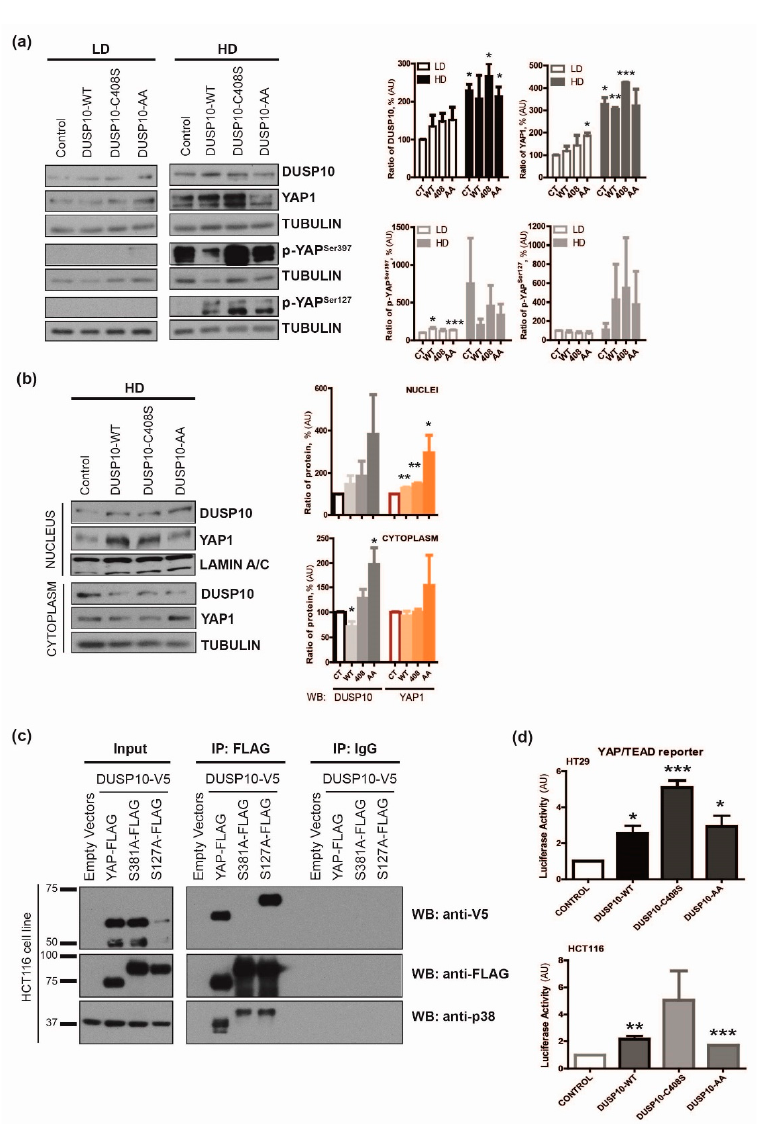
Figure 4. DUSP10 interacts with YAP1 through Ser397 residue. ( a ) Expression of DUSP10, YAP1, p-YAP Ser397 , and p-YAP Ser127 proteins in DUSP10-wild type (DUSP10-WT), phosphatase catalytic site mutant (DUSP10-C408S), and p38 binding site mutant (DUSP10-AA) HT29 cell line in LD and HD. TUBULIN is the control protein. (Top) A representative image of three independent experiments. (Bottom) Quantification of all blots performed (mean ± SEM; Student’s t -test; * p < 0.05, ** p < 0.01, *** p < 0.001). ( b ) Analysis of DUSP10, YAP1, and p-YAP Ser127 proteins from nuclei and cytoplasm extracts of HT29 DUSP10 mutant cell lines in HD. LAMIN A / C and TUBULIN are used as nuclear and cytoplasm control proteins, respectively. (Left) A representative image of three independent experiments. (Right) Quantification of all blots performed (mean ± SEM; Student’s t -test; * p < 0.05, ** p < 0.01). ( c ) Immunoprecipitation of YAP-FLAG and detection of DUSP10 and p38 in HCT116. DUSP10-V5 and YAP-FLAG plasmids were co-transfected into the cell line and detected by anti-FLAG and anti-V5 antibodies, respectively. YAP1 wild type (YAP1-FLAG) and mutant (S381A-FLAG, S127A-FLAG) plasmids were immunoprecipitated with anti-FLAG. Representative images of three independent experiments. ( d ) Relative luciferase activity of the 8xGTII-luc (YAP / TEAD binding element reporter) was measured in HD, responding to DUSP10 overexpression and DUSP10 mutant constructs. HT29 (Top graph) and HCT116 (Bottom graph) were transiently transfected with the indicated plasmids and its control constructs. Student’s t -test (mean ± SEM; ** p < 0.01, *** p < 0.001) and three independent experiments were performed. Completed immunoblots of Figure 4a–c are in Figures S11 and S12,